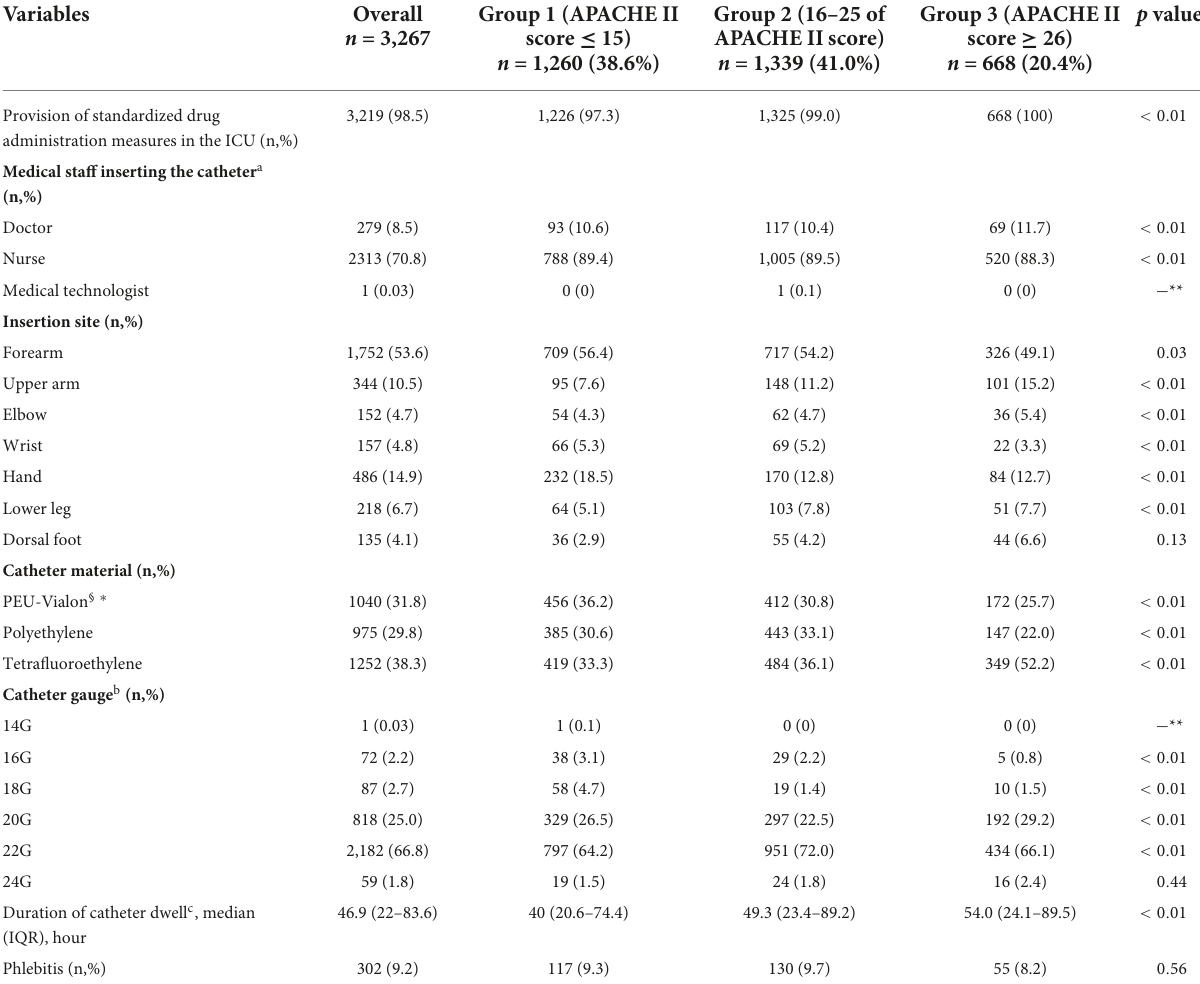
TABLE 2 All PIVC characteristics during insertion stratified using the APACHE II